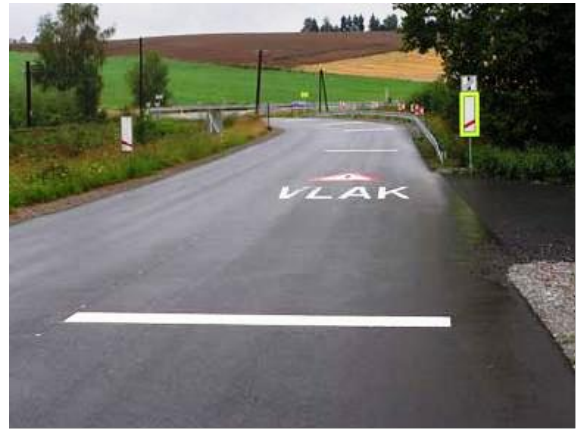
Figure 2. Level Crossing Highlighted by Optical Psychological Brake V18 (source Mr